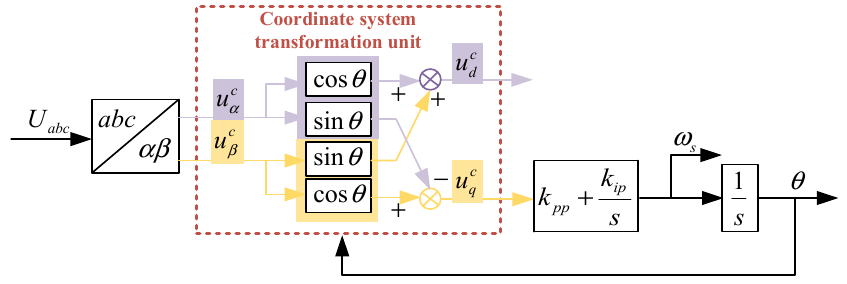
Figure 2. Control diagram of SRF-PLL.